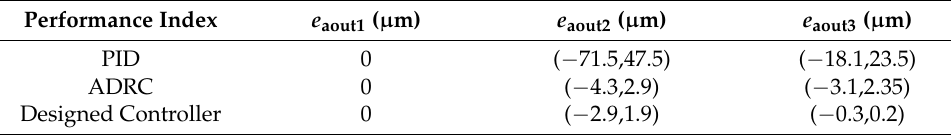
Table 5. Control range of each controller under speed